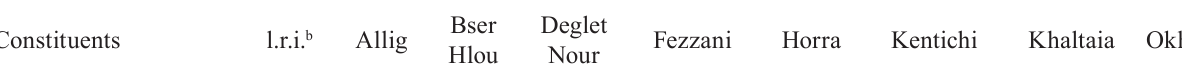
TABLE IV - Volatiles compositiona of date palm fruits obtained from eight varieties at Tamr stage (Cont.)